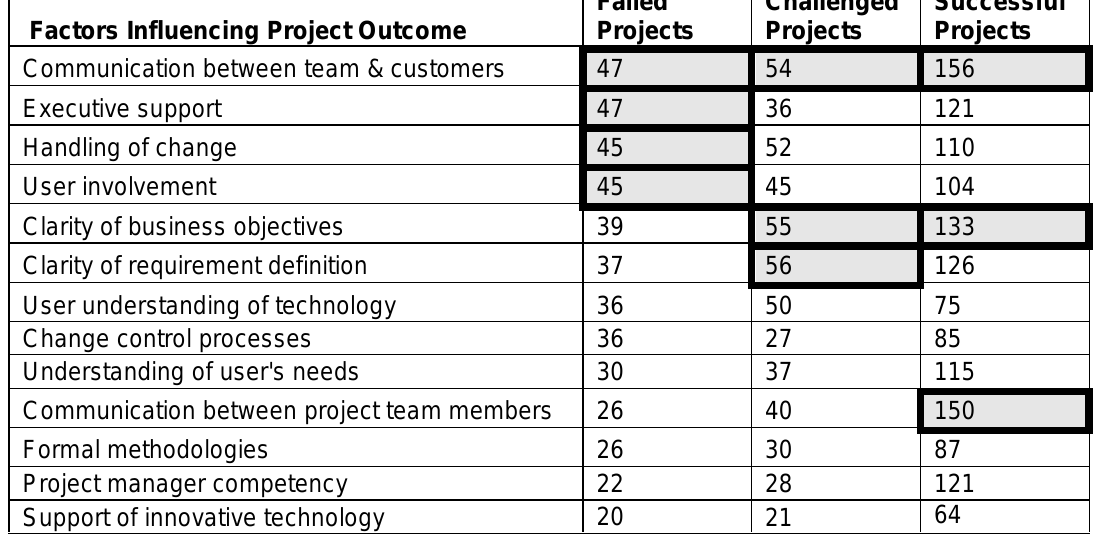
Table 3: Factors influencing project outcome Factors Influencing Project